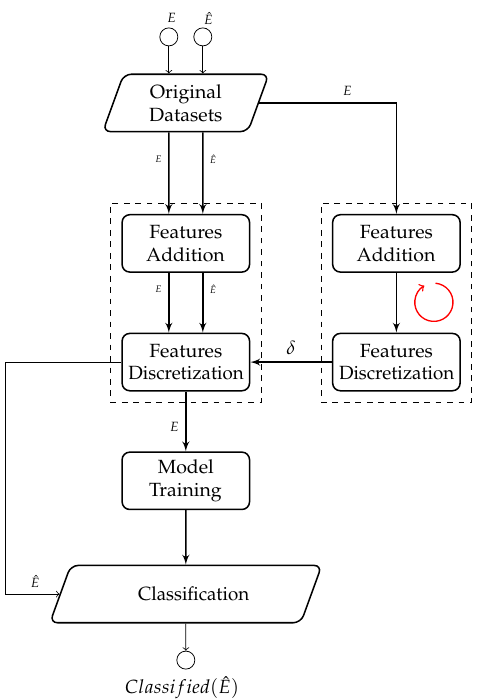
Figure 5. LFE high-level